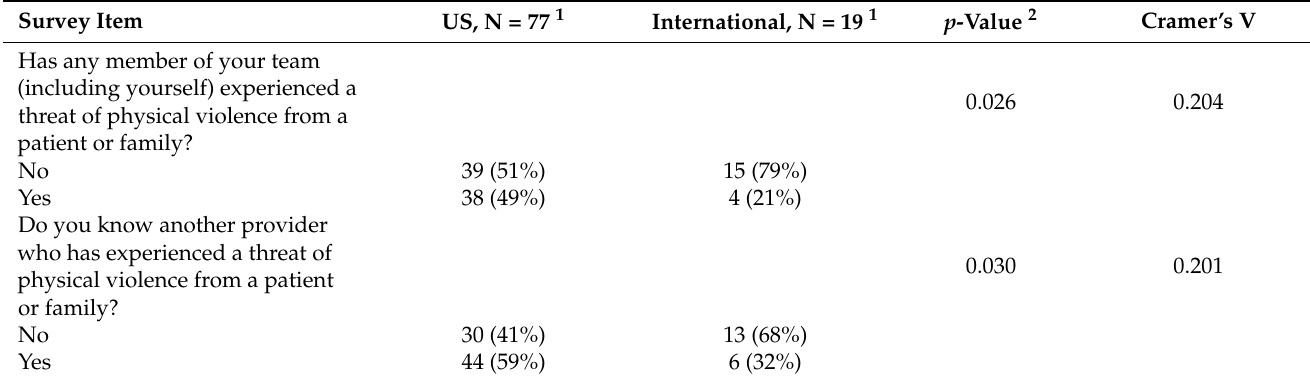
Table 3. Prevalence of Violence by Provider Location (Domestic vs. International).